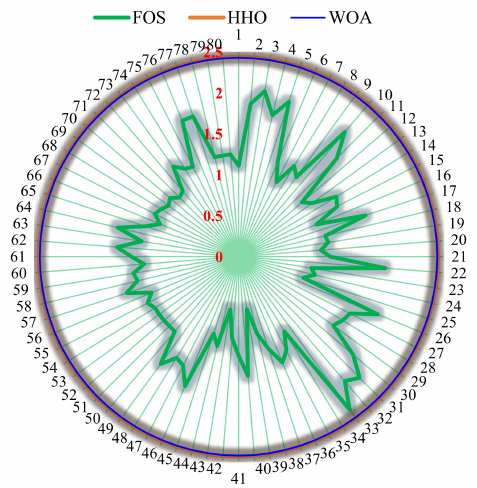
Figure 15. Comparison between different FOS and output of optimization